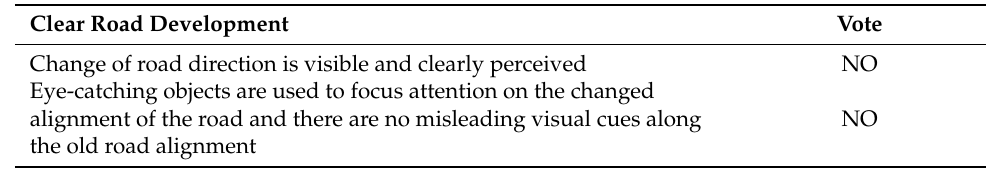
Table 12. Evaluations of the “clear road development” investigation topic. Clear Road